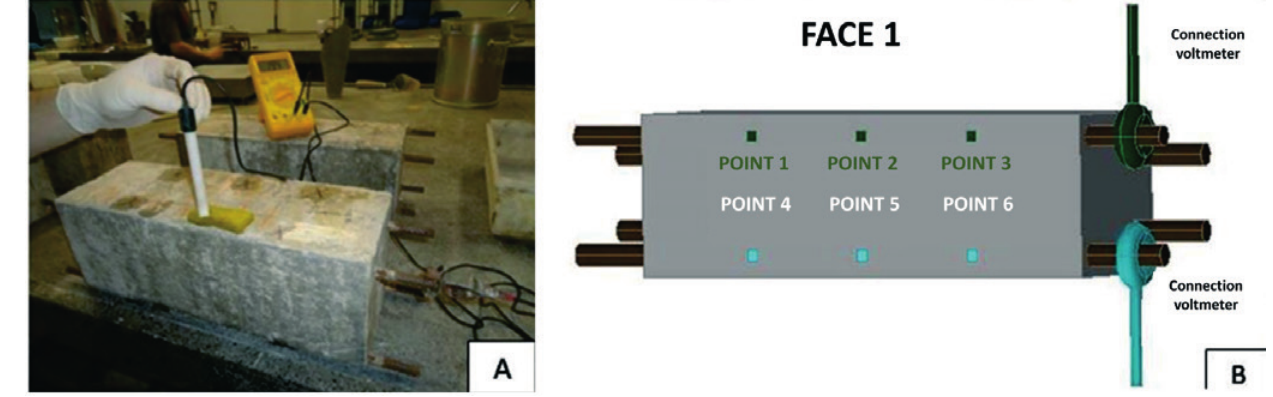
(A) Execution of test for determinating the corrosion potential with high impedance voltmeter; (B) Positioning of reading points with voltmeter